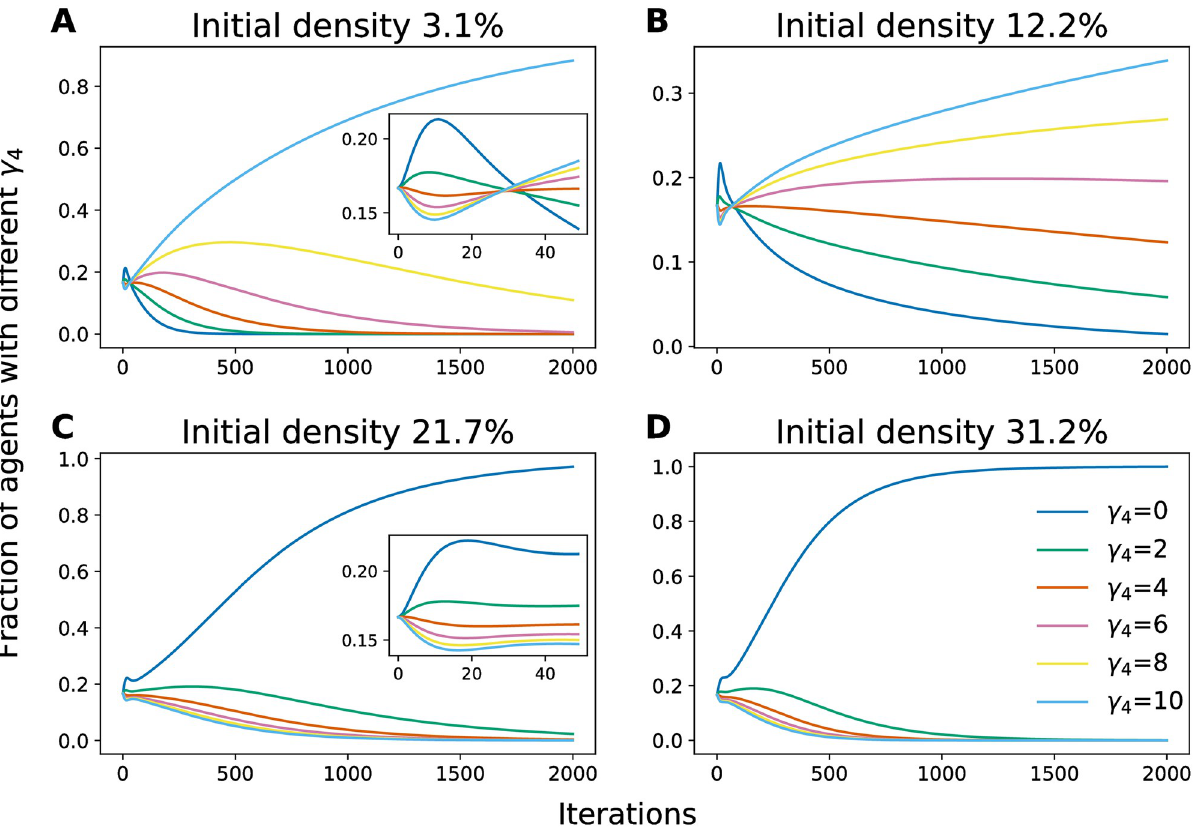
Fig 5. Numerical solutions of the coupled mean-field model at different initial densities. A-D show the evolution of the fraction of the population with each value of γ 4 in the mean-field model; insets at 3.1% and 21.7% initial densities show a zooming in of the initial transient dynamics from iteration 0 to 50. Initially in the evolution, γ 4 = γ max = 10 agents show a reproductive disadvantage, intuitively because agents with larger γ 4 tend to leave S 4 resource levels (with a relatively high birth rate) more often and produce less offspring, while later in the evolutionary process this disadvantage is overcome by γ 4 = γ max agents in low densities as they eventually find enough available S 5 sites to overcome their initial disadvantage. However, as density increases, other agents can quickly fill up S 5 sites and leave little opportunities for γ 4 = γ agents to overcome that initial disadvantage. Note max that b 5 = 5 is used in these numerical solutions so that h γ 4 ( t ) i converges to 10 at low